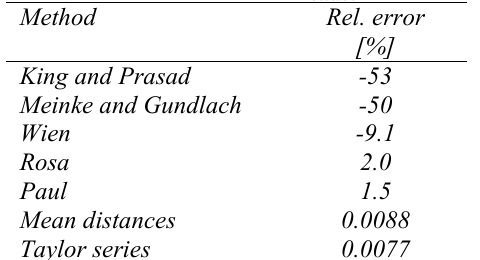
Table 4: Errors of the various methods for